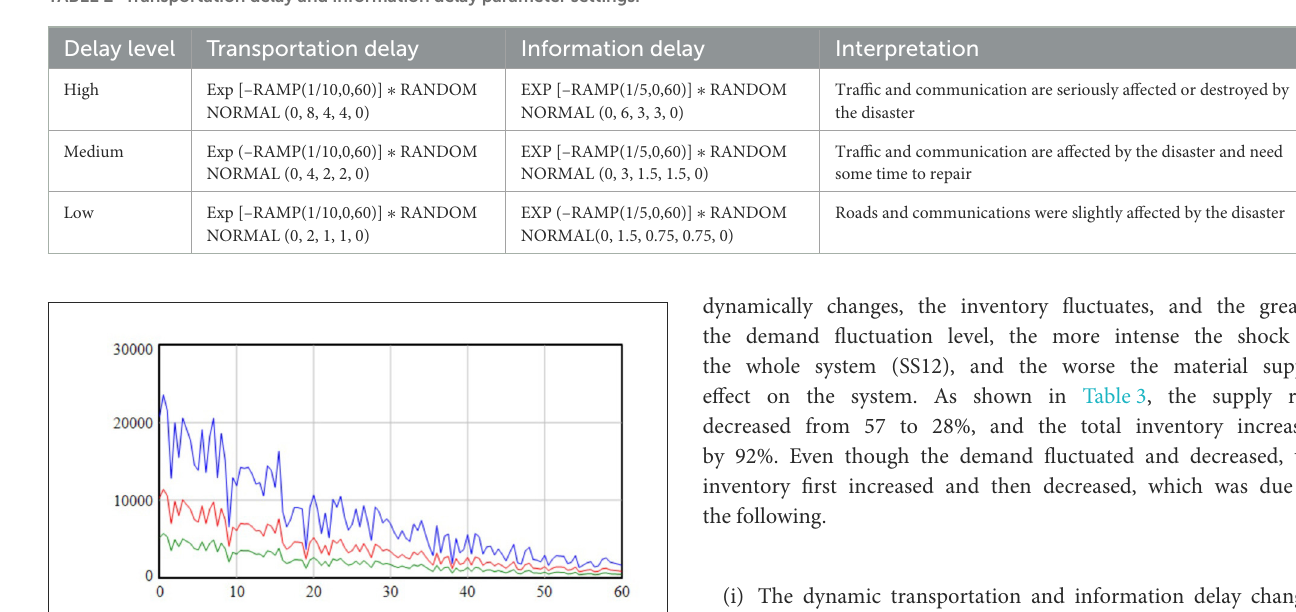
TABLE 2 Transportation delay and information delay parameter settings.